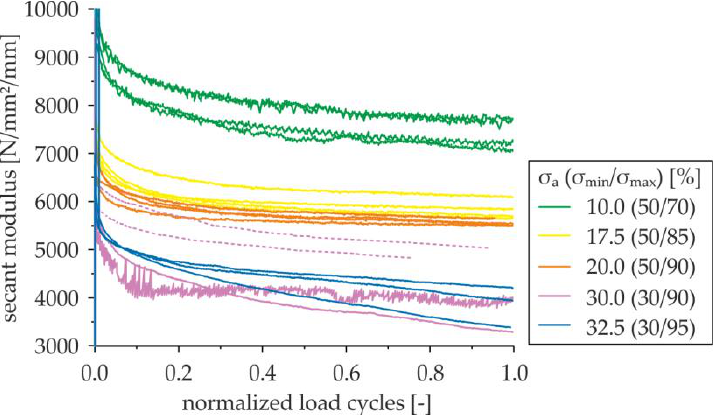
Figure 11. Comparison of the normalized development of the secant modulus depending on the amplitude (here: anchorage length = 3 a ).